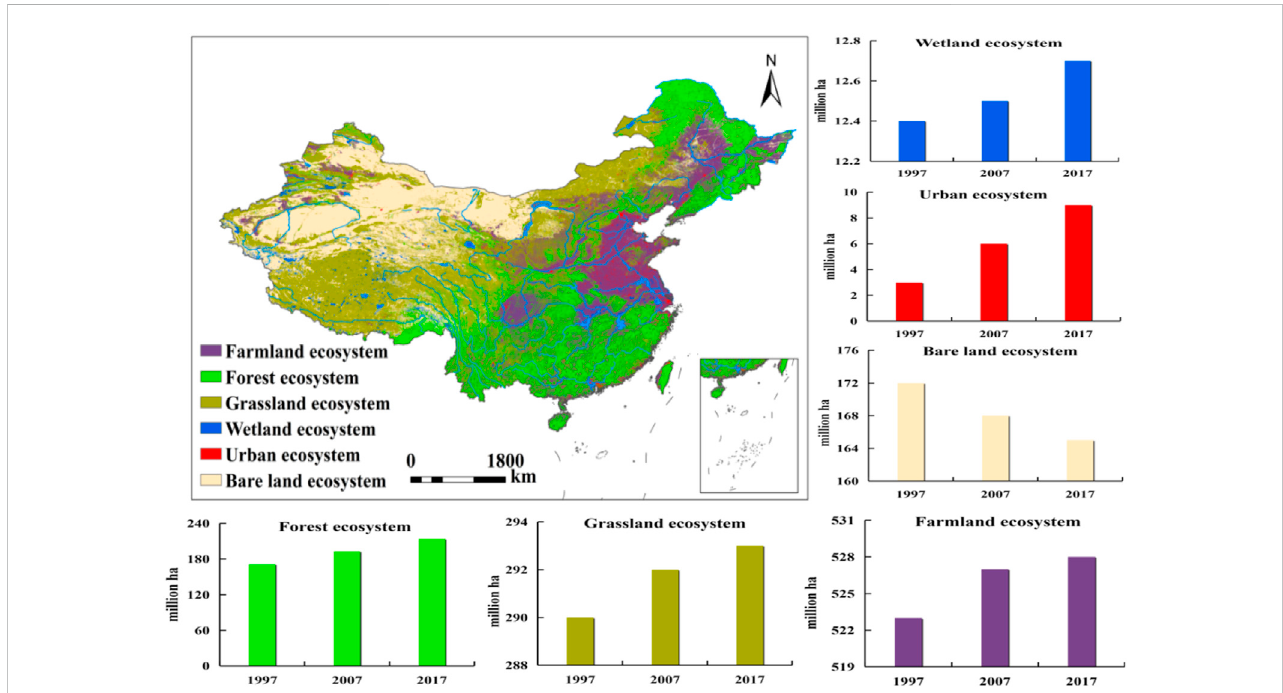
FIGURE 2 Distribution and changes of main ecosystem types in China. Note: the main ecosystem change data sourced from the World Bank (WB) (https://data. worldbank.org/accessed1October2021)andtheFoodandAgricultureOrganizationoftheUnitedNations(FAO)(https://www.fao.org/accessed10October 2021). LUCC data sourced from the Resource and Environmental Science Data Center of the Chinese Academy of Sciences (http://www.resdc.cn/ accessed on 1 May 2021).